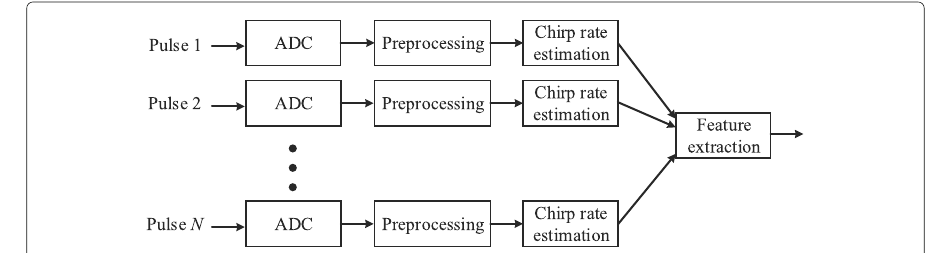
Fig. 1 The flowchart of recognition process to VGPO jamming